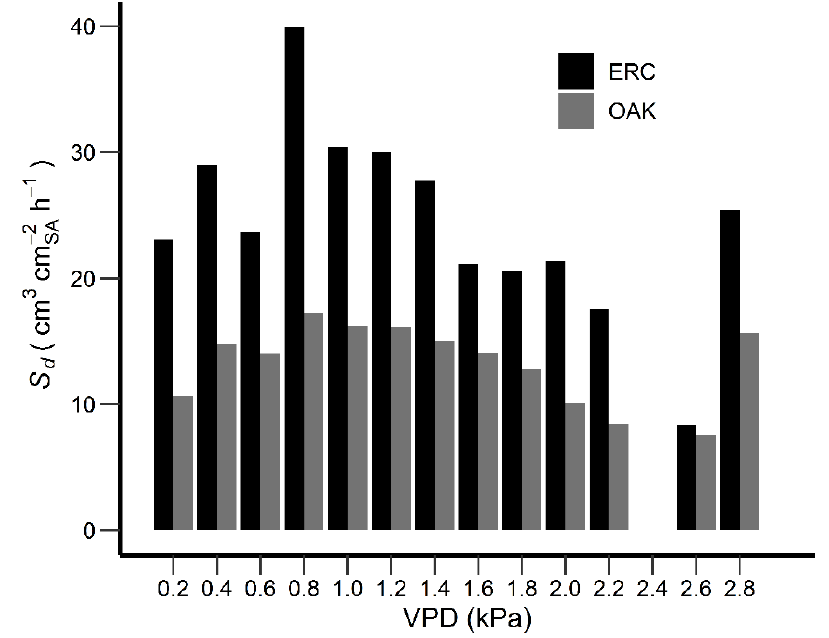
Figure 5. Relationship between daily mean sap flow density ( S d ) and daily mean VPD (kPa). 3.3. Water Use and Its Relationship with DBH, Sapwood Area and S d Mean sapwood area (± SD) was 113.8 ± 82.9 and 78.1 ± 40.4 cm 2 tree − 1 for post oak and redcedar, respectively (Table 1). Although the growing season daily average water use (WU ± SD) per tree was 32% higher for post oak compared to redcedar (13.9 ± 20.2 and 9.4 ± 10.8 L day − 1 , respectively), the maximum daily water use per tree was similar between species, with 27.9 ± 33.0 and 28.0 ± 25.9 L day − 1 for post oak and redcedar, respectively (Table 3). The water use of post oak trees in the MIX stand had its highest seasonal average (28.1 ± 32.7 L day − 1 ) for the spring of 2017, while the highest seasonal average for post oak trees in the OAK stand was 13.2 ± 17.0 L day − 1 for the spring of 2018 (Figure 6a). The highest seasonal water use of redcedar trees was 18.5 ± 11.19 and 23.5 ± 22.2 L day − 1 for ERC E and ERC M , respectively, in the spring of 2017 when soil moisture at multiple depths was generally high (Figures 2 and 6b,c). The seasonal average WU for the post oaks growing in different stands depended on the season ( p < 0.0001) and stand type ( p < 0.0001), and exhibited a significant interaction between stand and season ( p < 0.0001), with OAK M exhibiting between 43% and 64% greater WU than OAK O during spring, summer, and fall for both 2017 and 2018 (Figure 6a). Overall, redcedar trees in ERC M exhibited 26% higher WU than redcedar trees in ERC E for the entire study period, and the interaction between stand type and season was not significant (Figure 6c). When the WU of post oak and redcedar in MIX was compared (OAK M vs. ERC M ), seasonal WU was affected by species ( p < 0.0001), and season ( p < 0.0001), with a significant season and species interaction ( p < 0.0001). Seasonal average water use of OAK M was 48%, 40%, and 58% higher than that of ERC M ( p < 0.05) for the summer of 2017 and the spring and summer of 2018, respectively (Figure 6b).